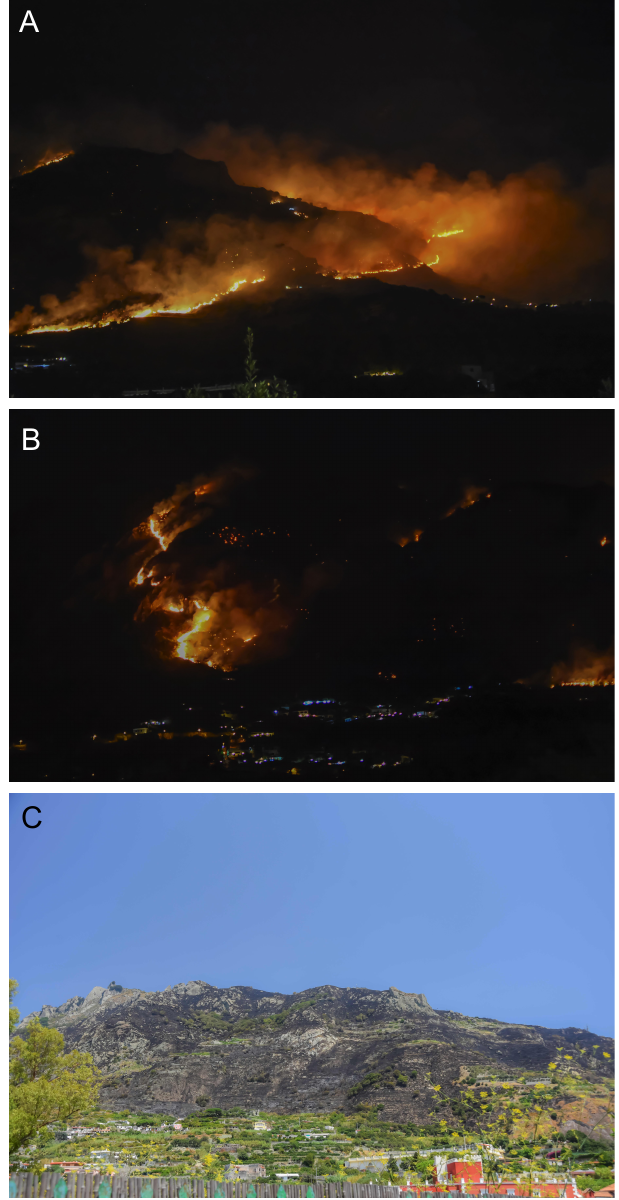
Figure 2: [A] and [B] Photographs of the August 2017 fire that engulfed the wooded southwestern slopes of Mt. Epomeo. [C] Photograph of the charred volcanic slope following the fire. Photographs taken by, and used with permission from, Michele Abbagnara.